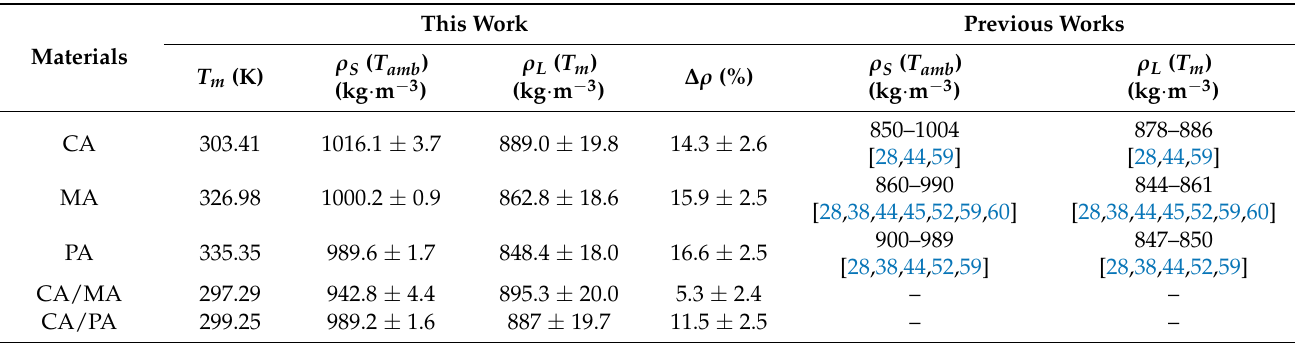
Table 6. Densities at ambient temperature in the solid state ( ρ S ), at melting temperature in the liquid state ( ρ L ) and volume expansion ( ∆ ρ ) of the three pure fatty acids and the two eutectic compositions. Comparison with the literature ([28,38,44,45,52,59,60]) at pressure p = 0.1 MPa